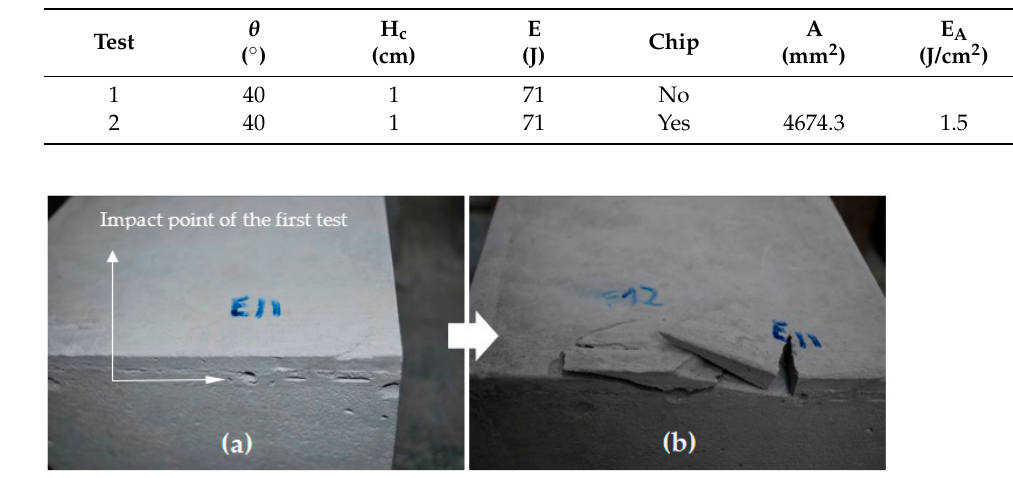
Figure 10. Specific energy as a function of volume removed in samples with a c/s ratio of 3:1. Table 4. Summary of the results of the test of the affected zone. (The precision of the measures is of the order of 0.5 ◦ for θ and 0.1 cm for H C . Besides, the precision of the scanner 3D is 5 mm).